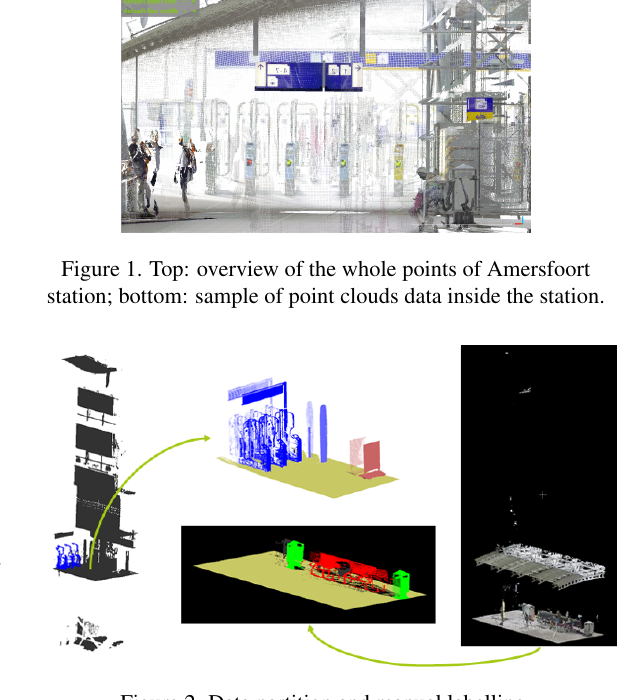
Figure 2. Data partition and manual